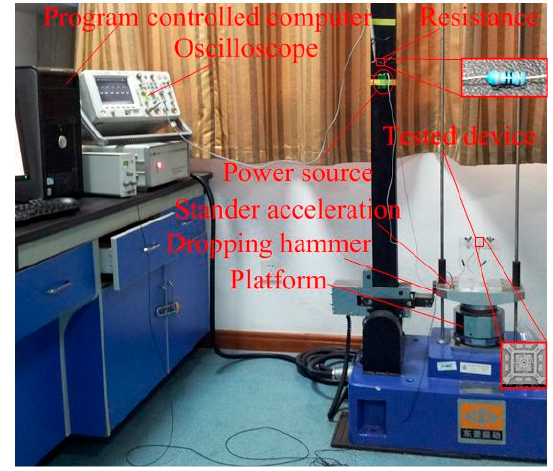
Figure 11. The dropping hammer system.